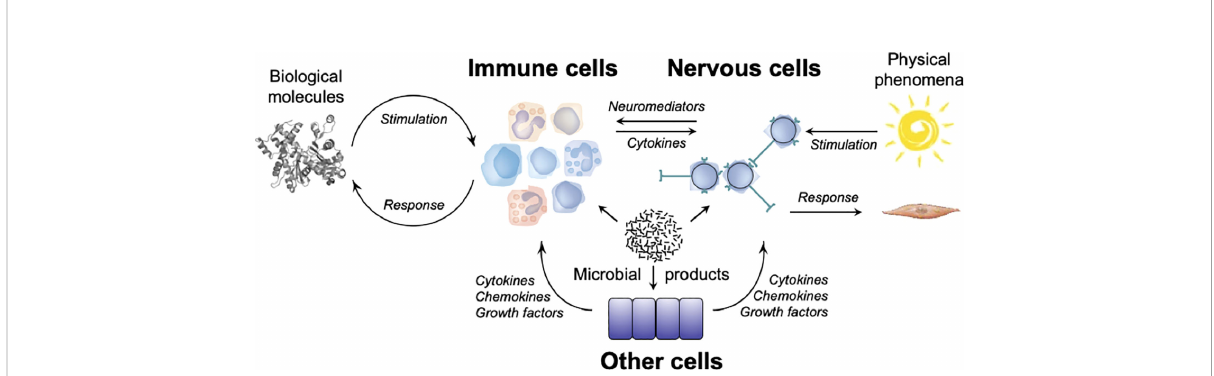
FIGURE 1 The cognitive and functional repertoires of the immune system and of the nervous system. Biological molecules stimulate immune cells that express immunoreceptors (TCRs, BCRs, NCRs) or pattern recognition receptors (TLRs, NLRs, CLRs), leading to the production and/or the activation of effector cells (T lymphocytes, ILCs, myeloid cells), and of molecules (cytokines, antibodies) which act on biological molecules that triggered the response. Physical phenomena stimulate sensory receptors of the nervous system which engender nervous in fl uxes that propagate in neural networks, leading to the activation of effector cells (skeletal muscles, smooth muscles) that act on the organism. Microorganisms and/or their products can stimulate immune cells by engaging immunoreceptors (TCRs, BCRs, NCRs) on lymphocytes and ILCs, and pattern-recognition receptors (TLRs, NLRs) on myeloid cells, nervous cells (neurons and glial cells) and other cells ( e.g. epithelial cells). Molecular and cellular immune effectors can act on organisms that triggered the response, but also on neurons that express cytokine receptors. Neuronal effectors can act on immune cells that express receptors for neuromediators. Effector molecules ( e.g. , cytokines, chemokines, growth factors, etc.) secreted by other cells ( e.g. epithelial cells) can act on immune cells ( e.g. , ILCs) and nervous cells ( e.g. , sensory